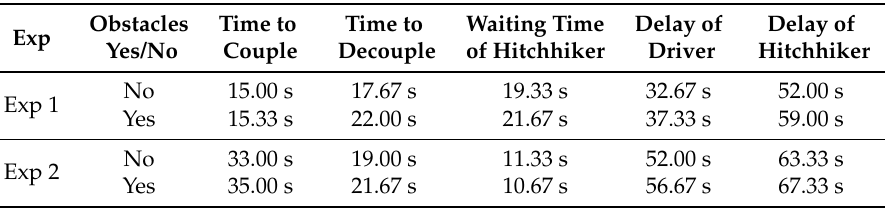
Table 2. Average time of the hitchhiking